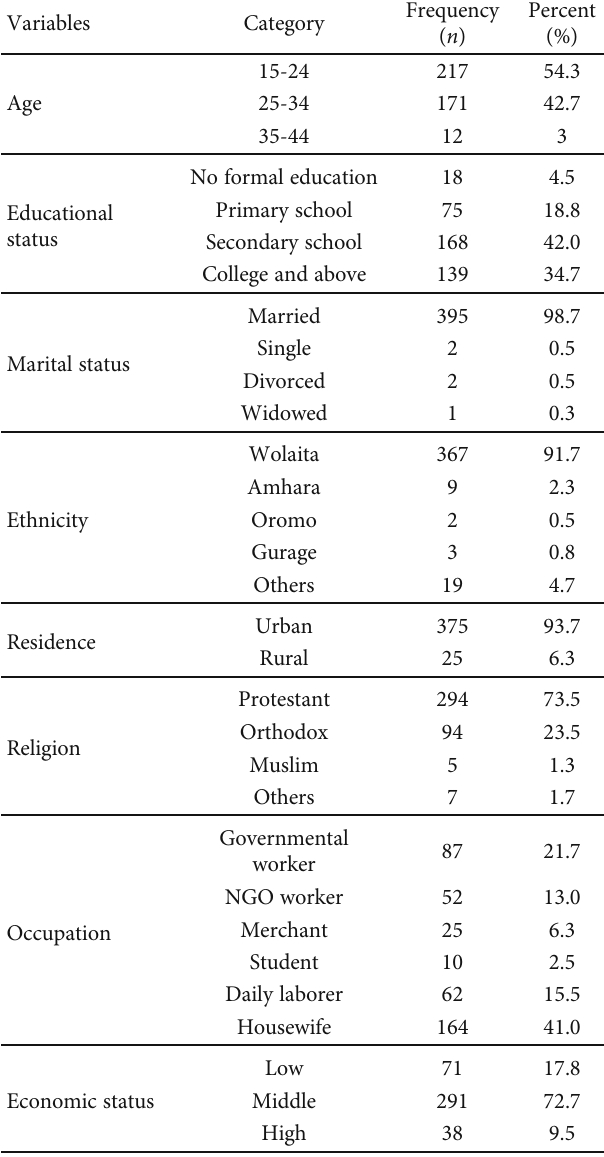
Table 1: Sociodemographic characteristics of pregnant women ( n = 400 ) attending antenatal care in Sodo town health facilities, Southern Ethiopia,